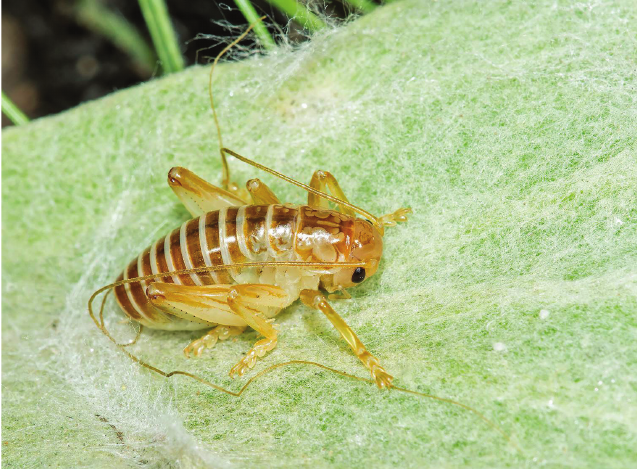
Fig. 1. Glomeremus sp. 1. From the Drakensberg, South Africa, il- lustrating the long, curled antennae and the silk matting on the inner surface of the leaf shelter. Body length about 15 mm.